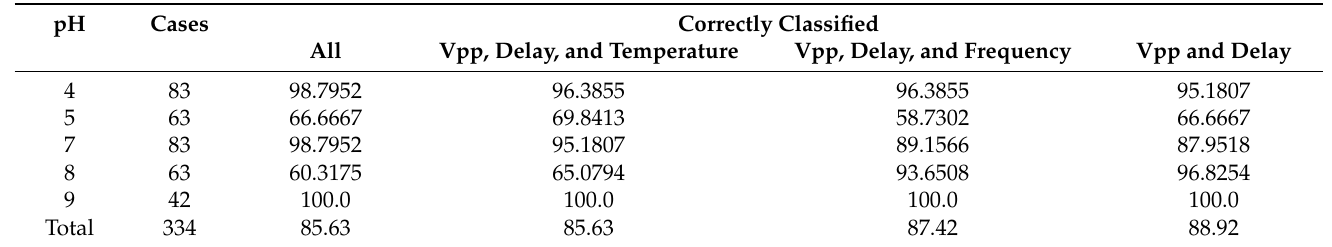
Table 19. Correctly classified cases with PNN using different input information for the selected data.